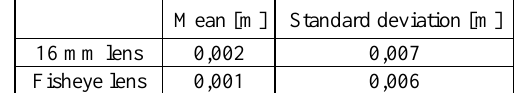
Table 8. Statistical values of set of distances for floor.